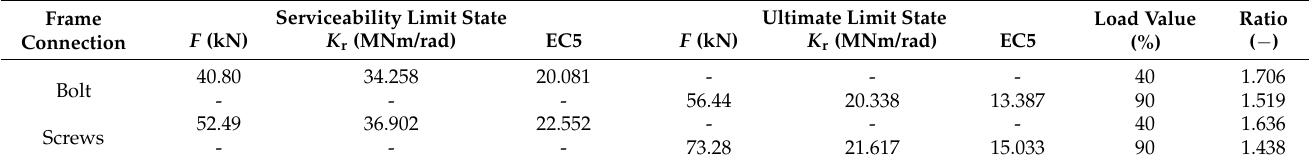
Figure 27. Process of rotational stiffness of frame connection, test sample no. 2. Table 9. Table of stiffness.